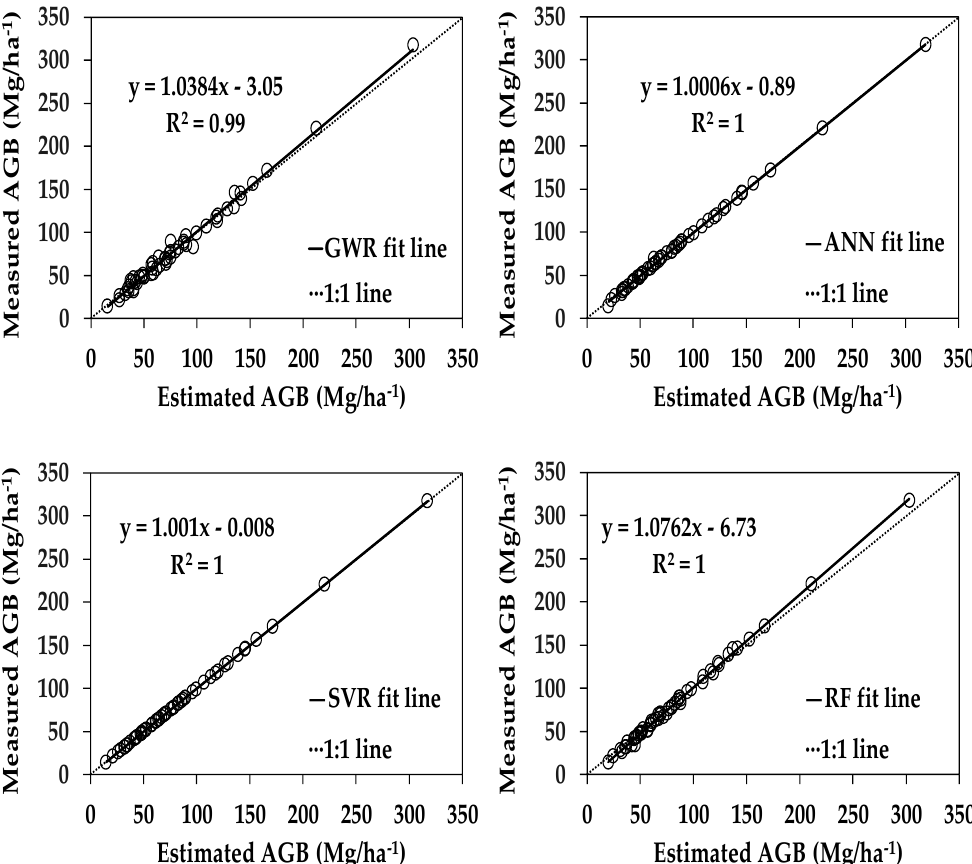
Figure 5. Scatterplots of the measured and estimated above-ground biomass (AGB, Mg·ha − 1 ).